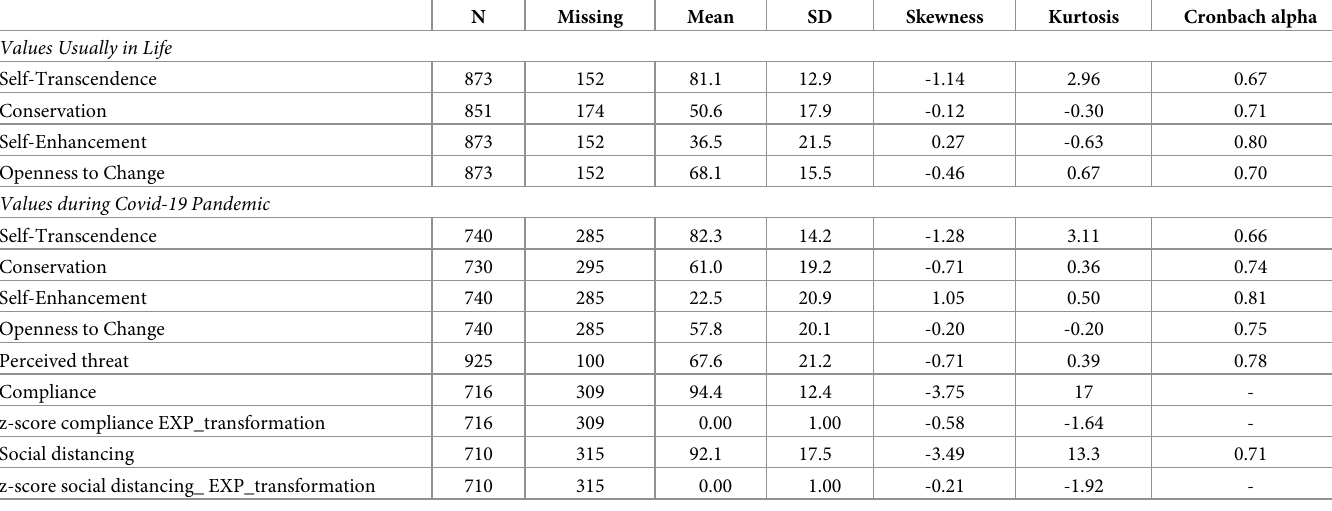
Table 1. Descriptives of the variables (N, missing data, mean, SD, Skewness, Kurtosis and Cronbach